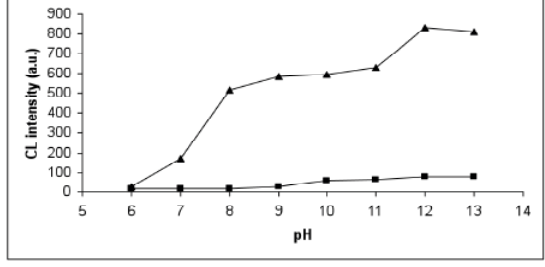
Figure 2. The effect of pH in the absence ( ■ ) and in the presence( ▲ ) of 40 mg L -1 PVK. Reagent 1: 1% (w/v) CTMAB, 30% (v/v) DMF.